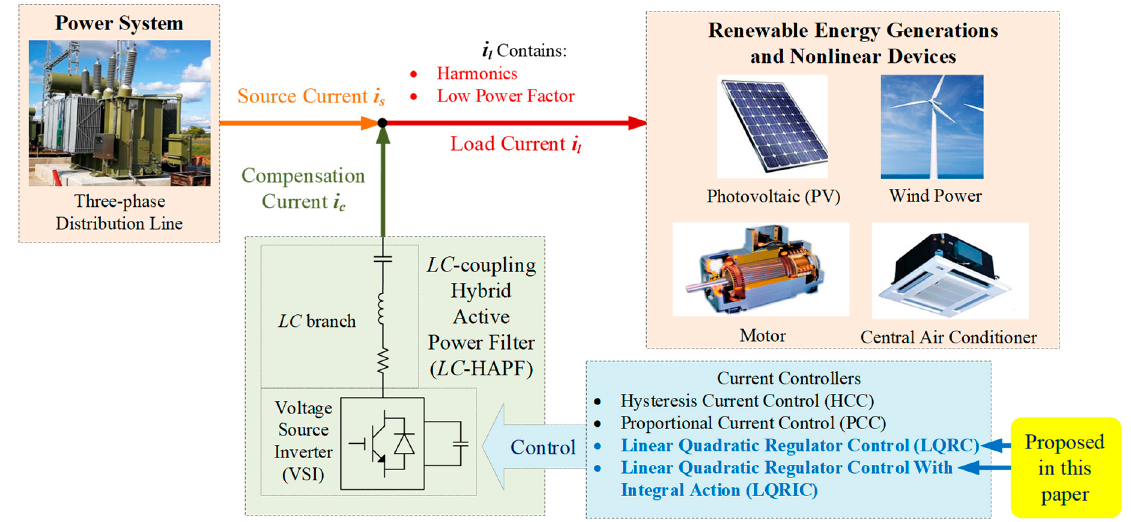
Figure 1. The graphical abstract. The contributions of this paper are summarized as